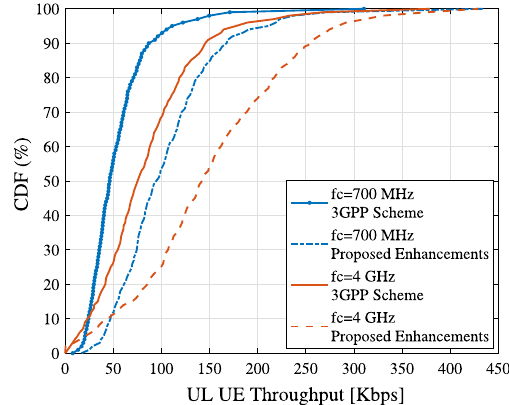
Fig. 13 User throughput CDF with 40% duty cycle